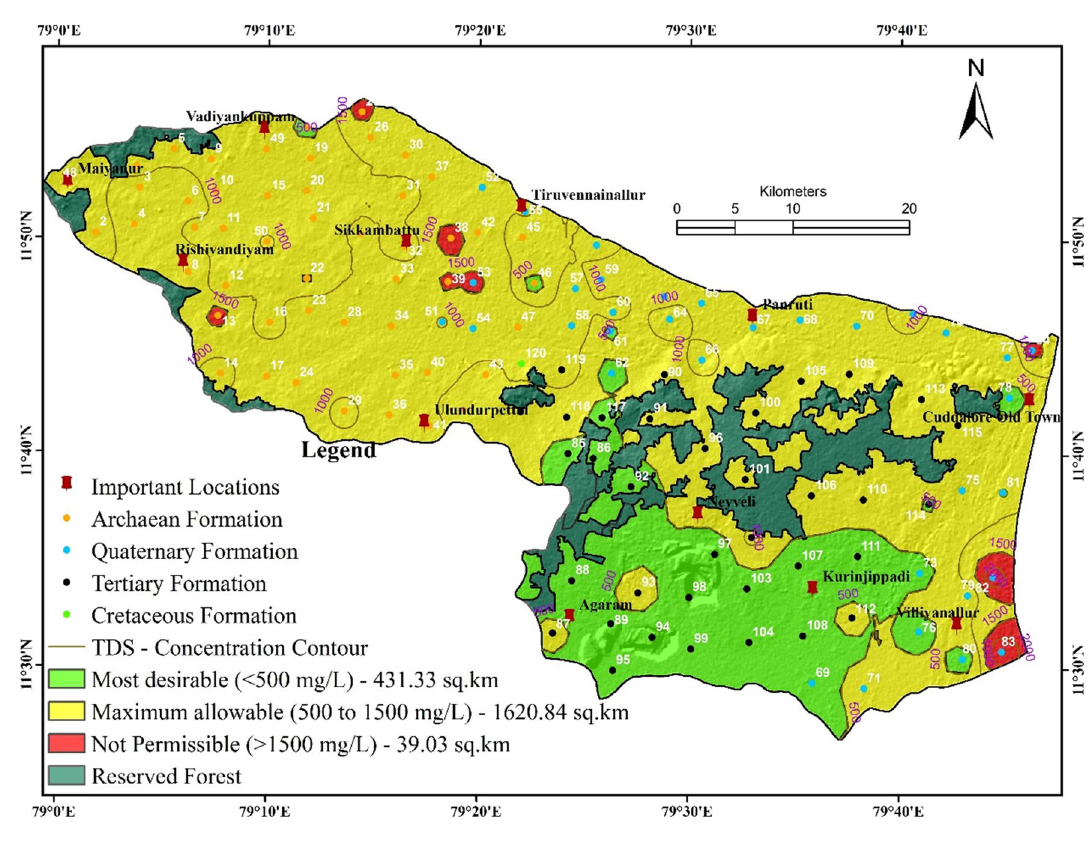
Fig. 5 Groundwater quality map—TDS rainy (November